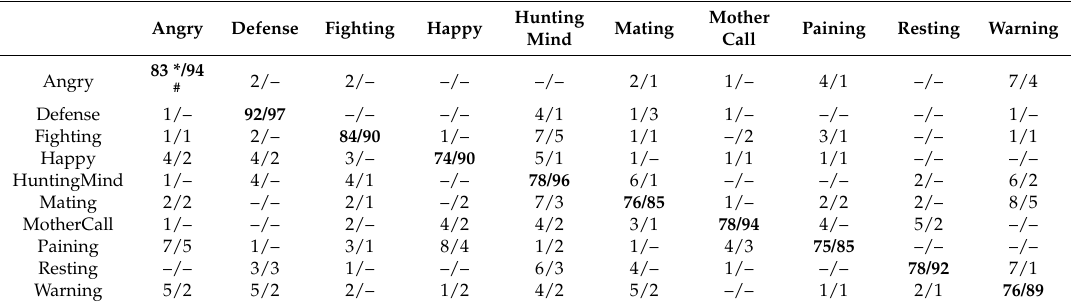
Table 4. The confusion matrix of the best performing ensemble classifier on 3x_Aug dataset using CDBN features with GAP and FDAP. The first number represents the number of confused cat sounds using GAP and second using FDAP, illustrated as GAP/FDAP format.